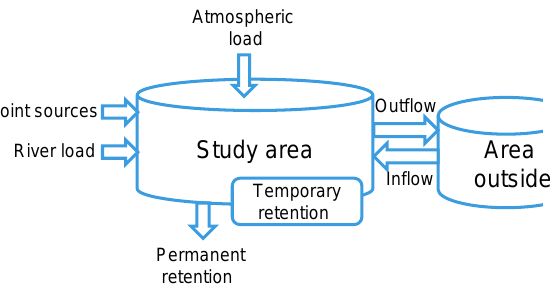
Figure 1. Simplified scheme of the retention calculations in the study area. Permanent retention is considered a permanent removal of nutrients from the ecological system and includes burial and, for nitrogen, also denitrification. Temporary retention is defined as the changes in nutrient inventory in the active sediment layer and wa- ter column. The temporary retention may change sign depending on whether the nutrient inventory increases or declines.